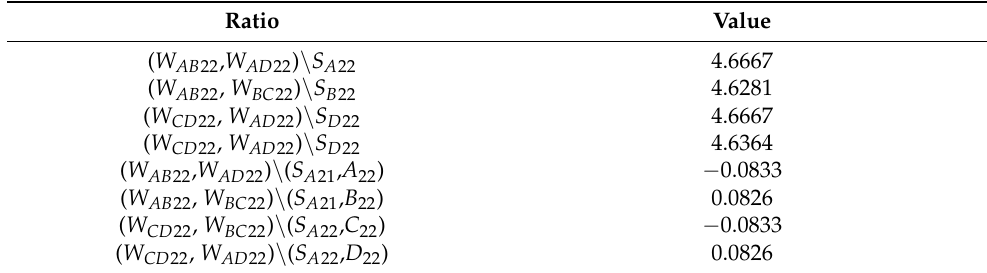
Table 6. The initial data defining the mesh B v 22 .